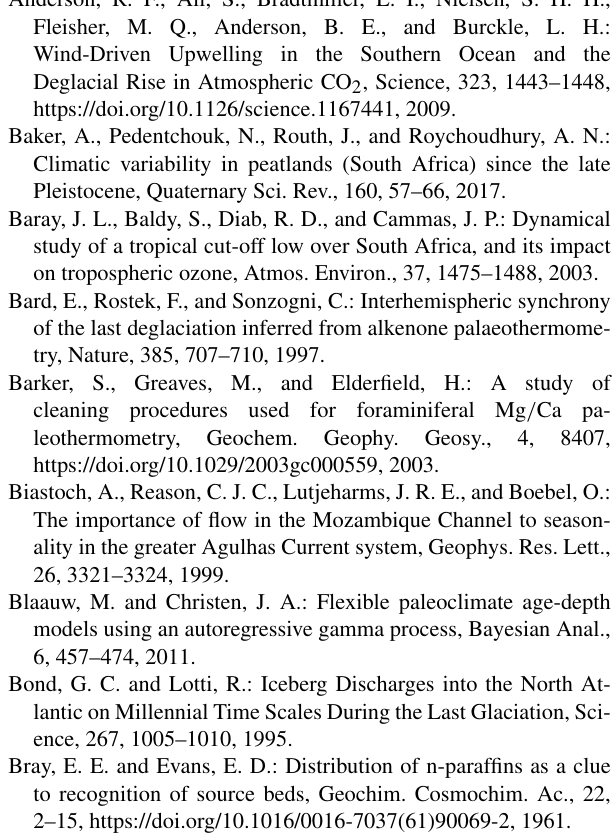
Supplement. Table S1: GeoB20616-1 oxygen and carbon iso- topic composition of planktonic foraminifera ( G. ruber ). Table